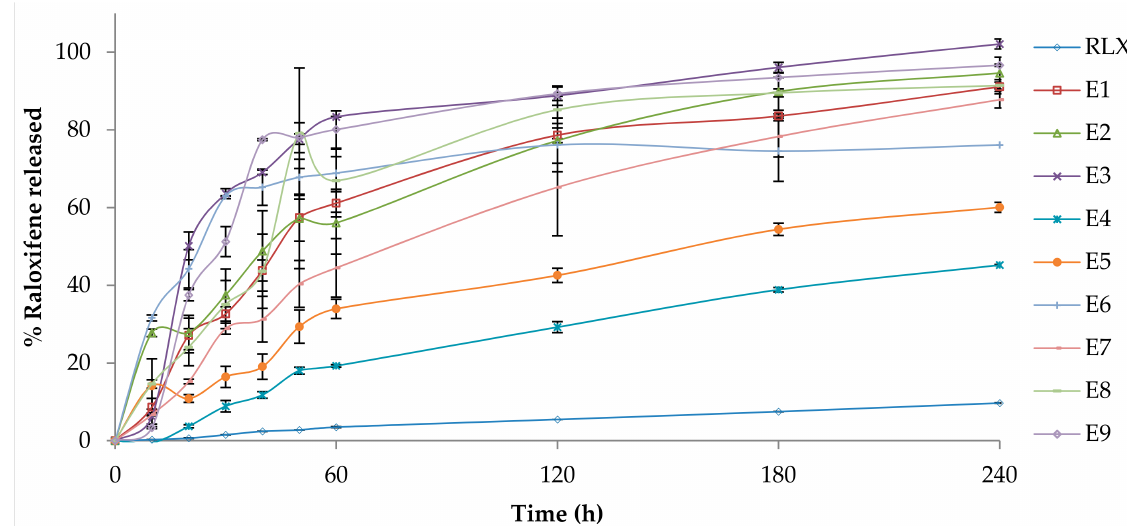
Figure 4. In vitro drug release profiles from RLX-loaded nanofibers (E1–E9) in comparison to RLX aqueous dispersion, in phosphate buffered saline (pH 6.8 of 0.1% w / v tween 80) at 37 ± 0.5 ◦ C (mean ± S.D., n =